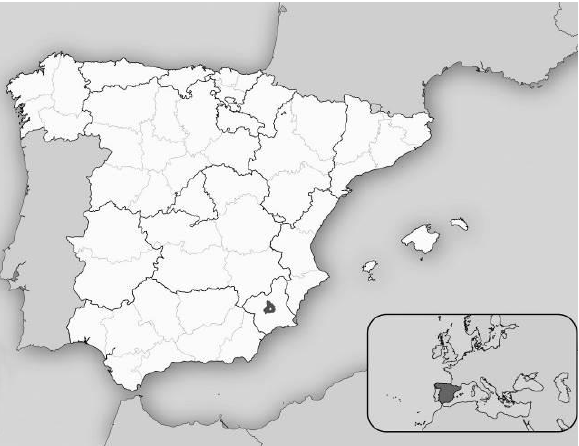
Figure 1. Map showing the location of Mula in the Region of Murcia and Spain (Source: Wikipedia and